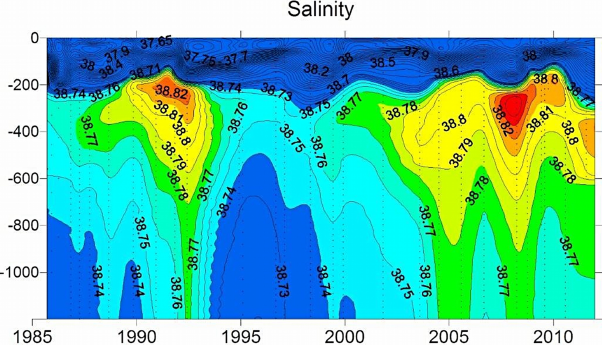
Fig. 13. Time–depth diagram of the salinity variations in the Sicily Channel. Two episodes of the salinity maximum at the depth of the LIW are evident in the early 1990s and in the second half of the 2000s associated with BiOS and impacting the WMDW and Western Mediterranean Transition pre-conditioning (modified from Gaˇci´c et al.,